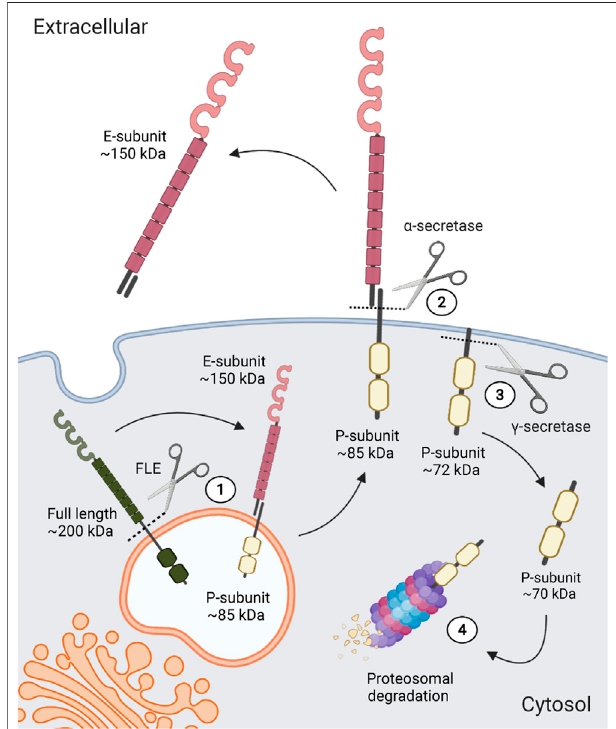
FIGURE 2 | LAR-RPTPs proteolytic processing. After its translation, LAR-RPTPs are processed in the trans-Golgi by furin-like endoproteases (FLE) (1) , to later be translocated to the cell surface, where they will be integrated into the membrane as a complex of two subunits; the extracellular E-subunit and the intracellular P-subunit, who remain non- covalently bound. Extracellularly, α -secretase can also induce a cleavage in theectodomainoftheP-subunit (2) ,whichreleasestheextracellularportionof LAR-RPTPs. Also, intracellular tandem phosphatase domains are proteolytically processed by γ -secretase (3) , inducing LAR-RPTPs catalytic region internalization and its proteasomal degradation (4)